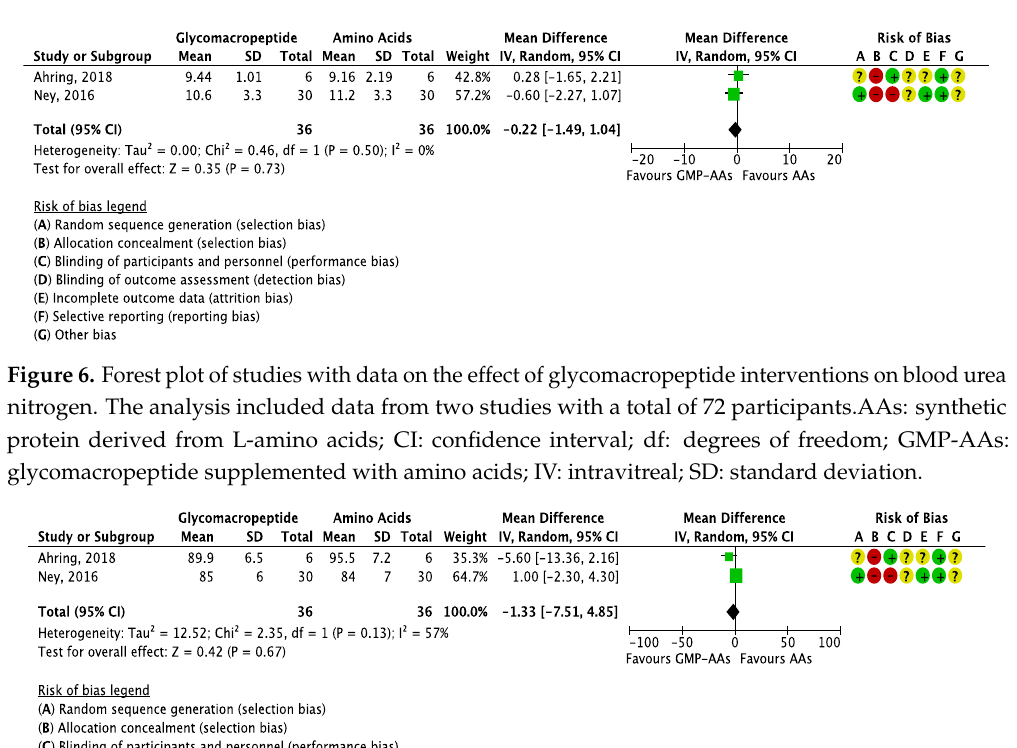
Nutrients 2018 , 10 , x FOR PEER REVIEW 12 of 17 Figure 5. Forest plot of studies with data on glycomacropeptide interventions on blood tyrosine levels. The analysis included data from two studies with a total of 72 participants.AAs: synthetic protein derived from L-amino acids; CI: confidence interval; df: degrees of freedom; GMP-AAs: glycomacropeptide supplemented with amino acids; IV: intravitreal; SD: standard deviation. The meta-analysis for BUN reported no significant differences between GMP-AAs and AAs (MD = −0.22 mg/dL (−1.49, 1.04); I 2 = 0%; P = 0.73; two studies; N = 72 participants; Figure 6); nor did the